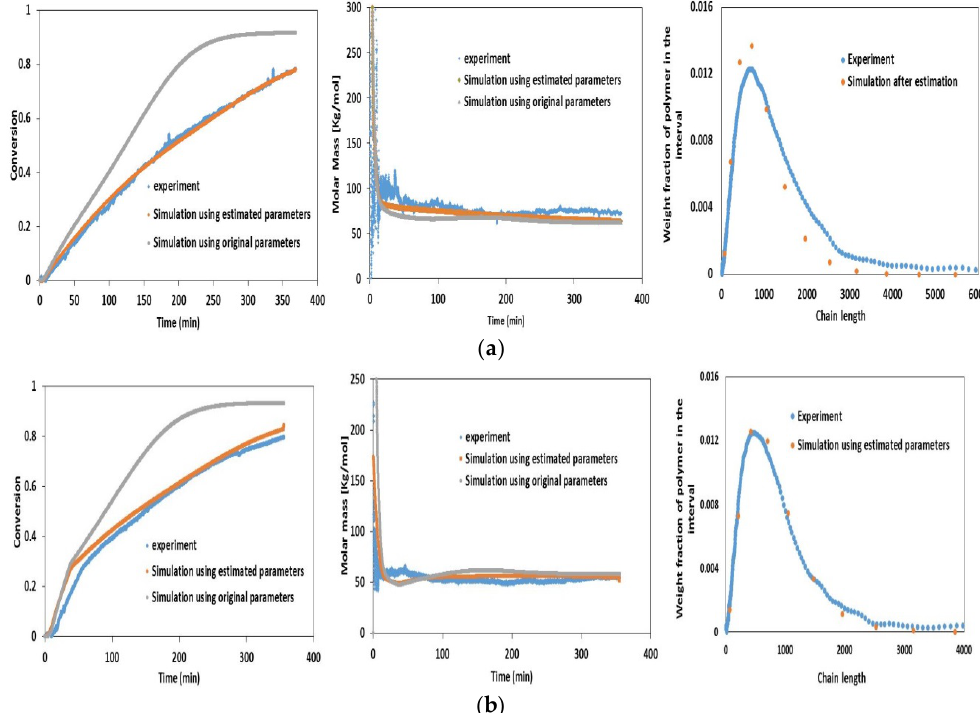
Figure 8. Comparison between experimental data and simulation with original and estimated parameters: ( a ) Isothermal experiment, ( b ) Non-isothermal experiment.